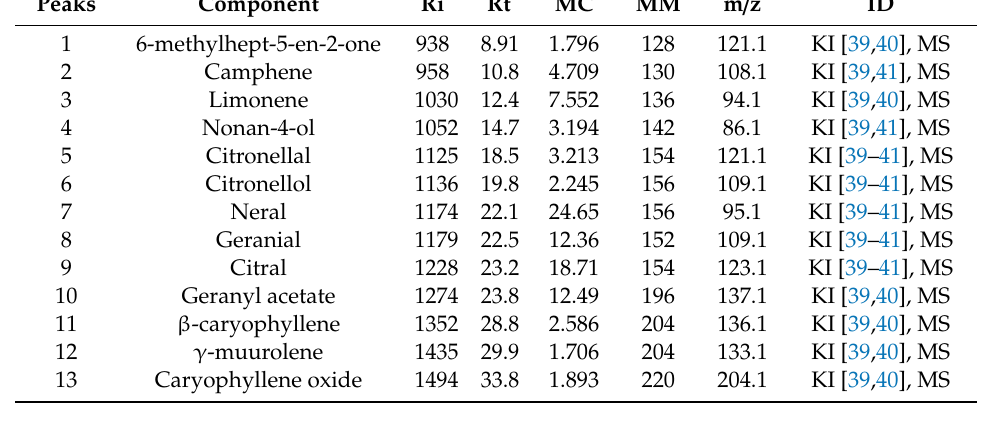
Figure 1. Gas chromatogram profiles of peak retention of components of the lemongrass essential oil: 6-methylhept-5-en-2-one (1), camphene (2), limonene (3), nonan-4-ol (4), citronellal (5), citronellol (6), neral (7), geranial (8), citral (9), geranyl acetate (10), β -caryophyllene (11), γ -muurolene (12), and caryophyllene oxide (13). Table 1. Chemical composition of lemongrass essential oil. Ri, retention indices; Rt, retention time; MC, mean composition (% area); MM, molecular mass; m / z, mass / charge ratio; ID, identification methods; KI, Kovats retention index on a DB-5 column and compared from the literature [39–41]; MS, mass spectra. Peaks